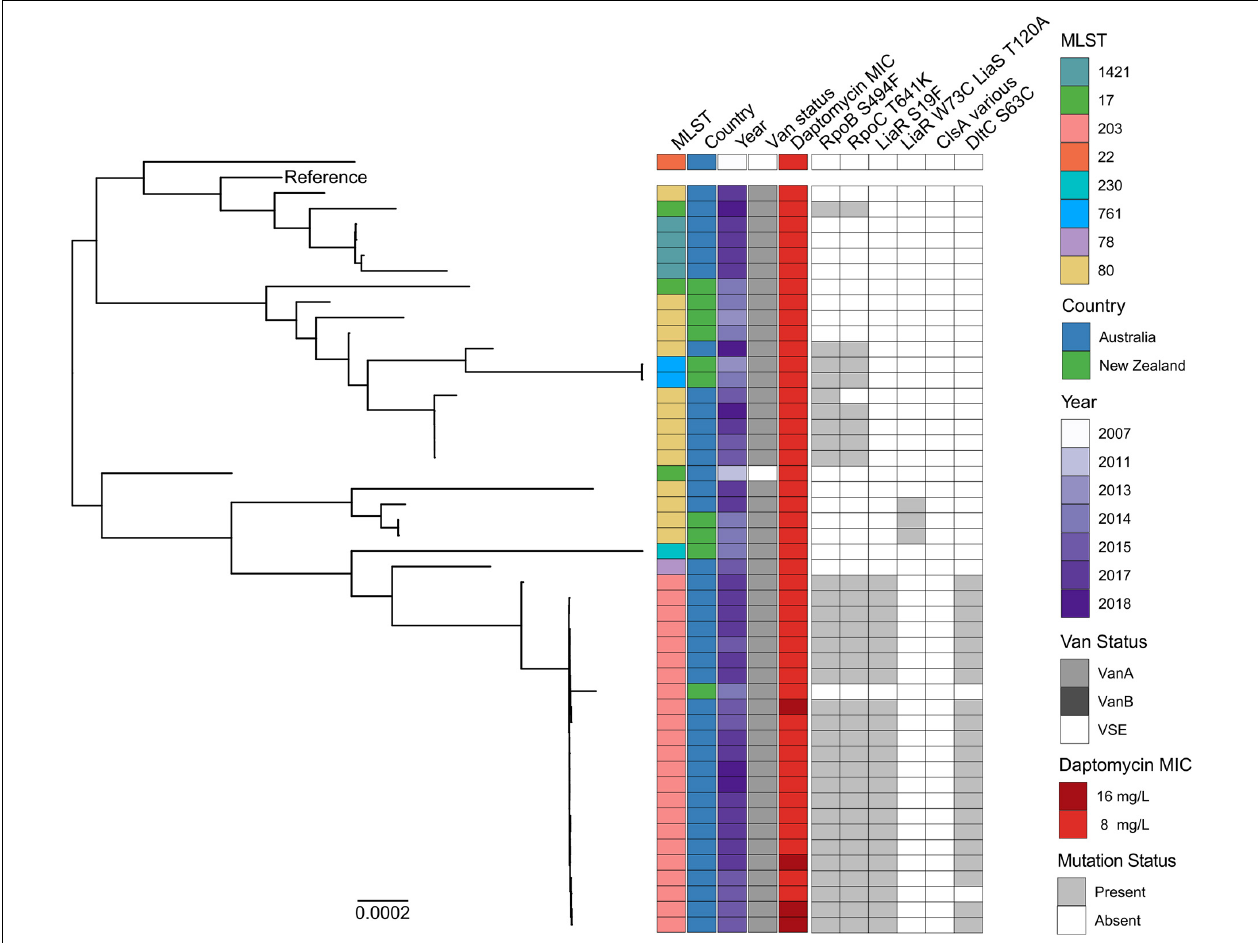
FIGURE 2 | Maximum likelihood core-SNP phylogeny of 49 Australian and New Zealand daptomycin-resistant E. faecium isolates. Coloured blocks show the multi-locus sequence type (MLST), country of origin (country), year of isolation (year), van status (i.e., vanA , vanB , and VSE) and daptomycin MIC (8 and 16 mg/L) for each isolate within the phylogeny. Grey blocks show the presence of the RNAP β -subunit S494F mutation (RpoB S494F), the RNAP β (cid:48) -subunit T641K mutation (RpoC T641K), the LiaR S19F mutation, the DltC S63C mutation, the LiaR W73C and LiaS T120A co-occurring mutations or mutations within ClsA previously associated with daptomycin resistance in VREfm (ClsA various). The vanA -VREfm strain D0 (TX16) (Diaz et al., 2014) was used as the reference.